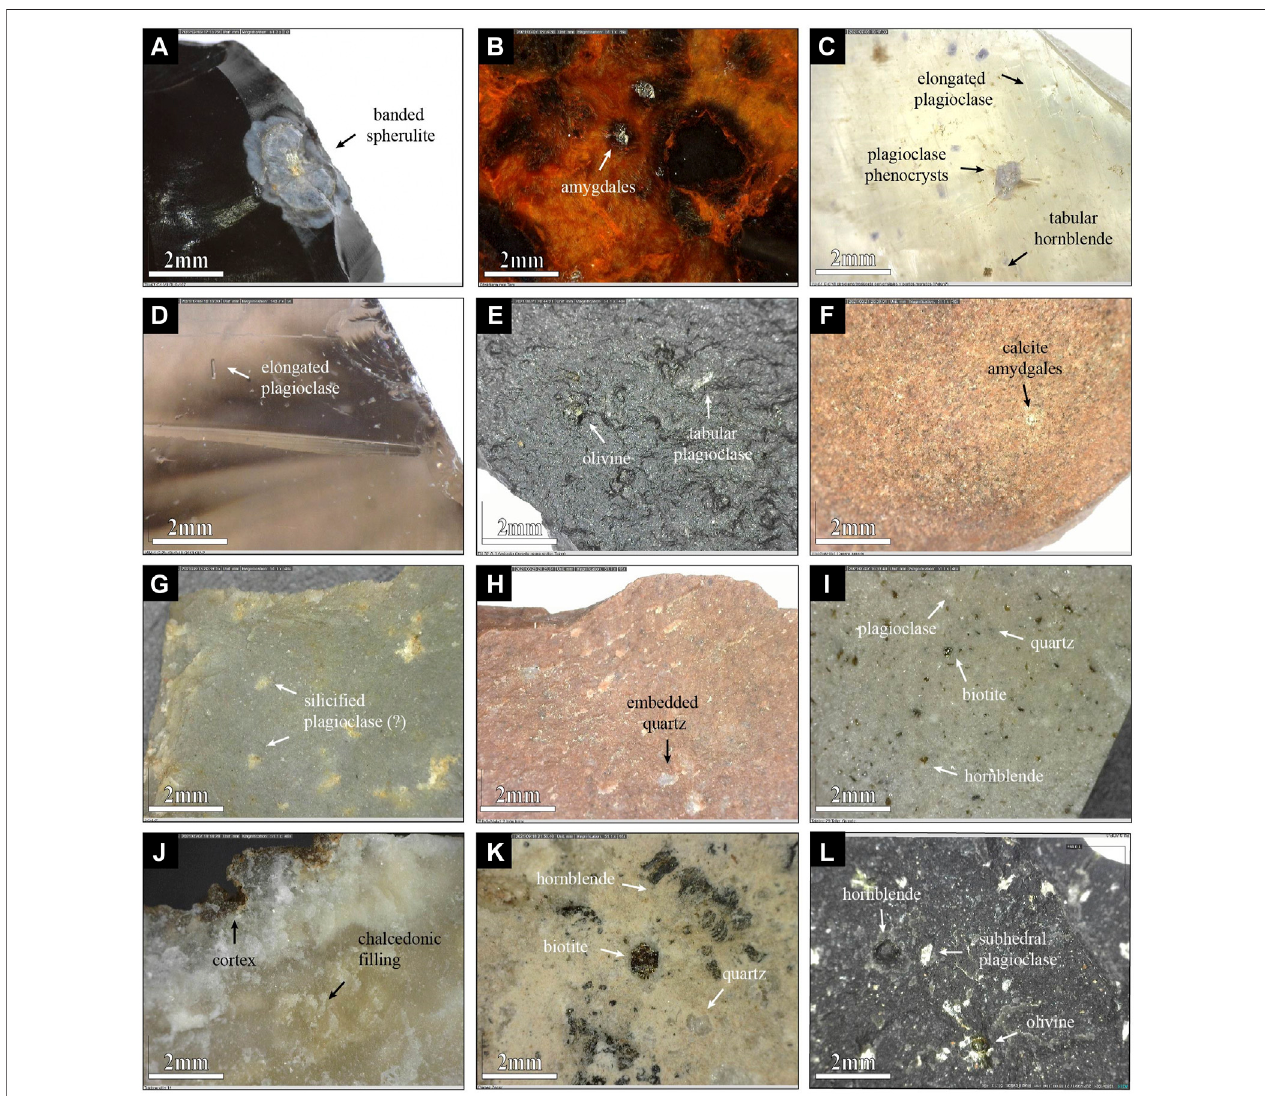
FIGURE 12 | Raw materials from known sources: (A) ; shiny black obsidian (OB-4); (B) Shiny reddish-black obsidian (OB-5); (C) translucent gray obsidian (OB-1); (D) translucent brown obsidian (OB-2); (E) Aphiric black andesite(AN-4); (F) devitri fi ed cineritic tuff(TF-2); (G) greenepidotizedsilici fi ed rock (SR-3); (H) brown andesitic tuff (TF-1); (I) gray-cream silici fi ed tuff (TF-7); (J) white chert (SR-1); (K) gray-pink pumice; (L) black hornblende andesite (AN-1).